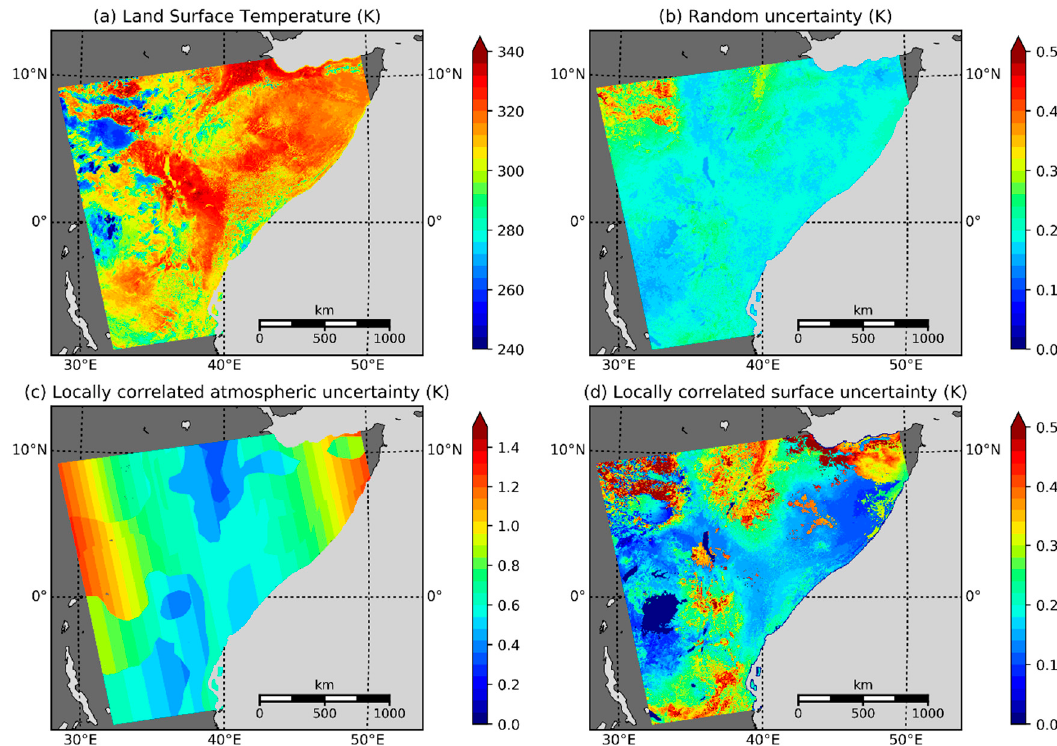
Figure 2. Aqua MODIS Level-2 land surface temperature (LST) data and pixel uncertainty estimates for 1 June 2010 at 10:50: ( a ) LST; ( b ) total random component; ( c ) locally correlated atmosphere component; and ( d ) locally correlated surface component. Note, the cloud mask is not applied in deriving the Level-2 output but is made available as a separate field in the product.